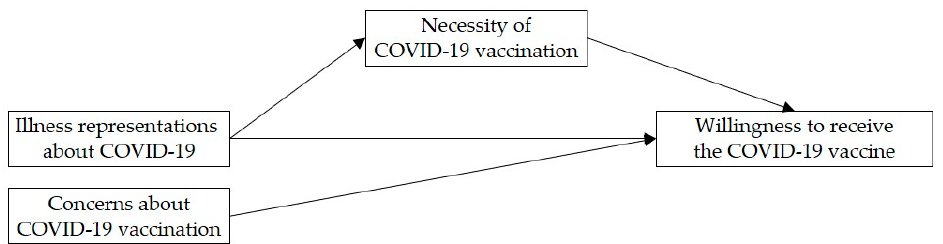
Figure 1. Theoretical model in which perceptions of necessity of COVID-19 vaccination (but not concerns about COVID-19 vaccination) mediate the relationship between illness representations about COVID-19 and the willingness to receive the COVID-19 vaccine.